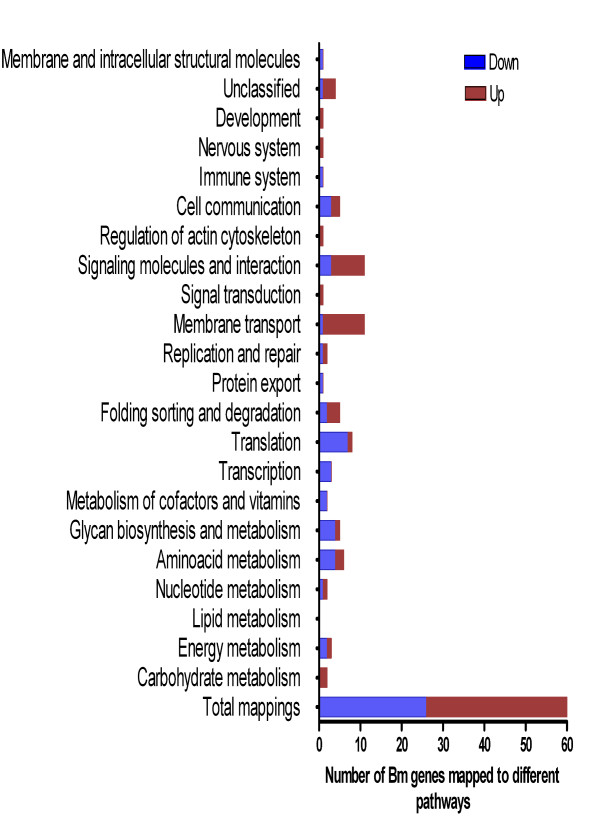
Distribution of KEGG pathways mapped to up-regulated and down-regulated Brugia malayi genes after doxycycline treatment. Many genes involved in transport, signaling, tanslation, metabolism and cell communication pathways were affected. Significant canonical pathways (P ≤ 0.05) and number of genes mapped in each pathway and their percentages are shown in additional file 12 for regulated genes.